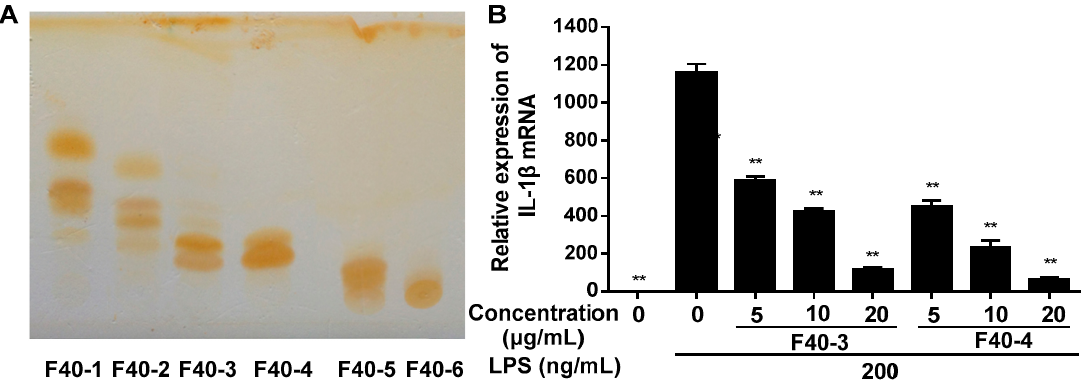
Figure 2. ( A ) Sub-fractions separated from F40 by silica gel chromatography. TLC was performed on precoated silica gel 60 F254 plates (Qingdao Haiyang Chemical Co., Ltd., Qingdao, China), developed with chloroform-methanol (4:0.1, V / V) and then exposed to the iodine vapor in a dark enclosed chamber for 10 min. ( B ) The relative expression of IL-1 β mRNA after treatment with sub-fractions of F40-3 and F40-4. RAW264.7 cells were pretreated with di ff erent concentration of di ff erent sub-fractions of F40 for 1 h, then treated with 200 ng / mL LPS for 6 h. Total RNA was extracted and genes expression levels were analyzed by RT-PCR in triplicate. The expression level of each gene was normalized to GAPDH mRNA. Data are expressed as mean ± SD ( n = 6). ** p < 0.01 vs. LPS treatment group.